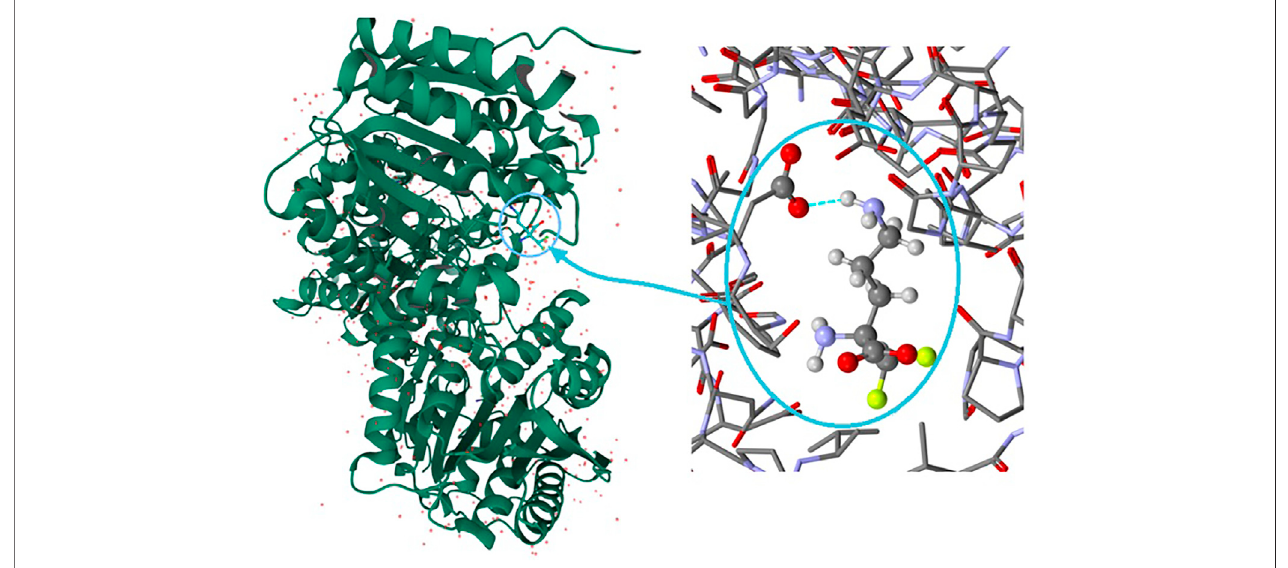
FIGURE 10 | On the left: the bio-complex of arginase with the DFMO ligand. On the right: the supramolecular synthon D (2) builded by amino and carboxy groups (PDB code: 3GN0) (Ilies et al., 2011).